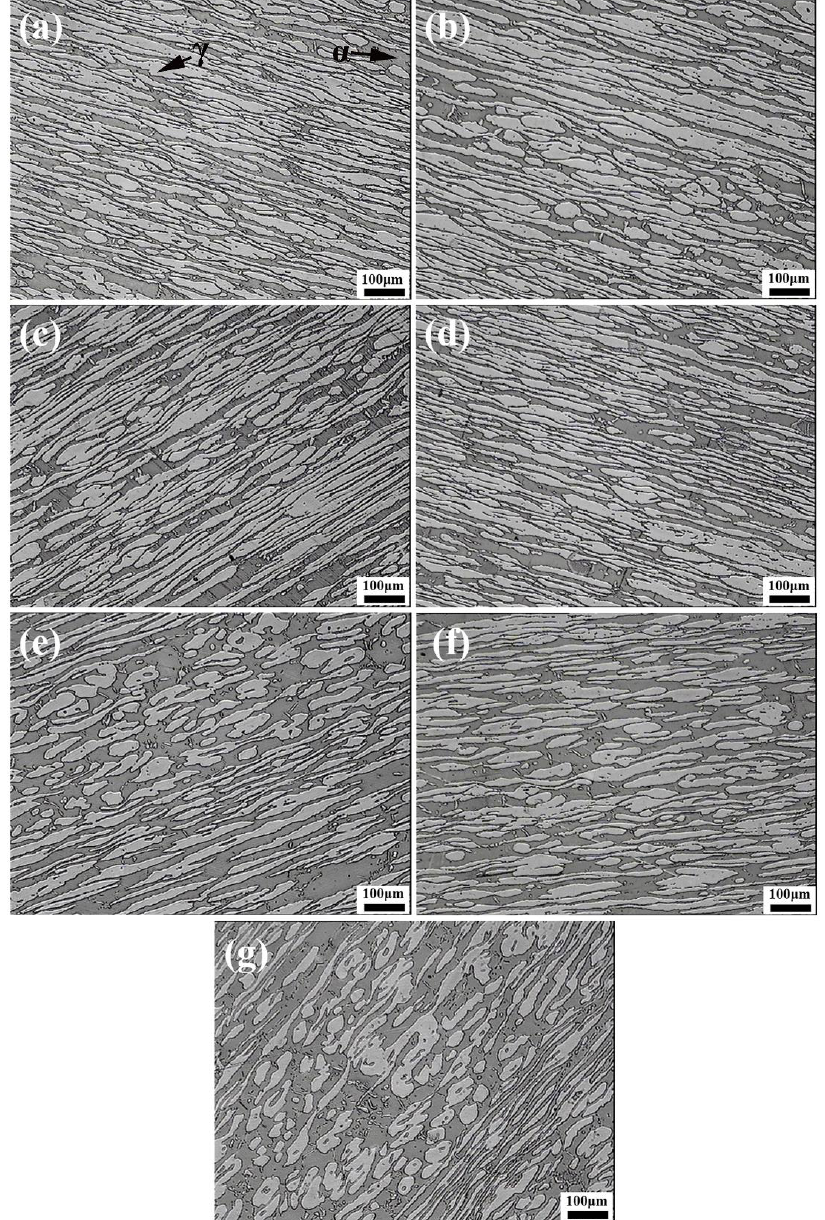
Figure 6. Microstructure of specimens with different cooling rates: ( a ) 0.25 °C/s; ( b ) 0.5 °C/s; ( c ) 1 °C/s; ( d ) 2 °C/s; ( e ) 5 °C/s; ( f ) 10 °C/s; ( g ) 20 °C/s.